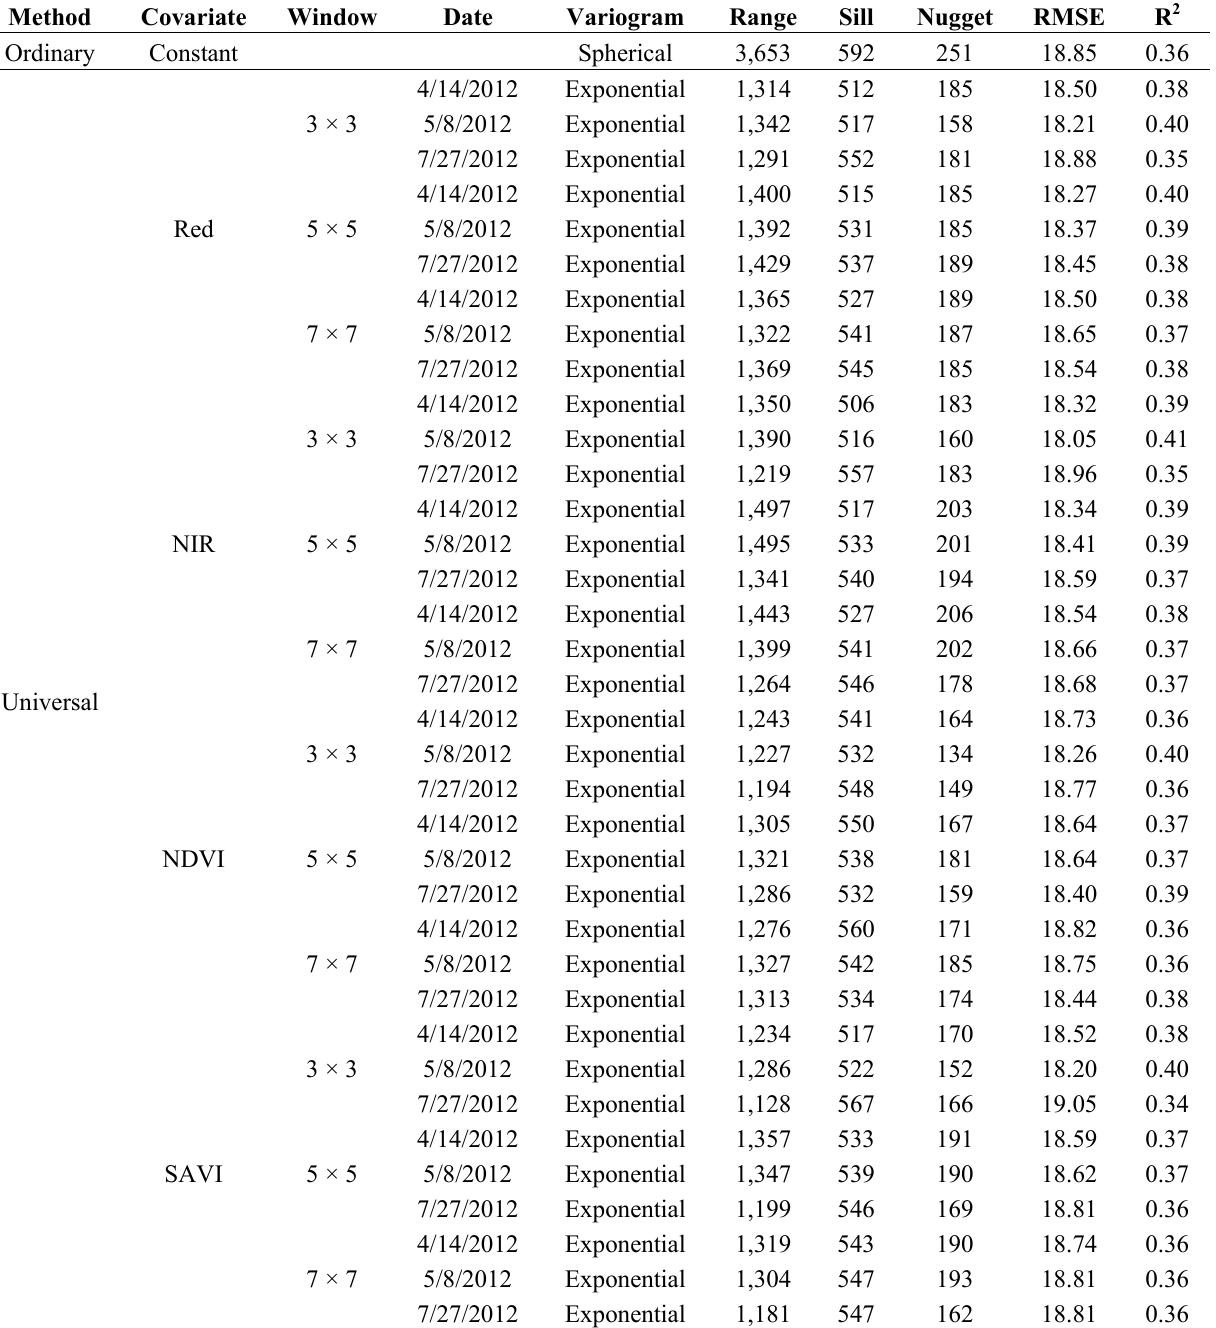
Table 2. Kriging variogram parameters and cross-validation results for weighted elephant utilization in the Chobe riverfront, Chobe National Park, Botswana. n = 257 for all models. Method Covariate Window Date Variogram Range Ordinary